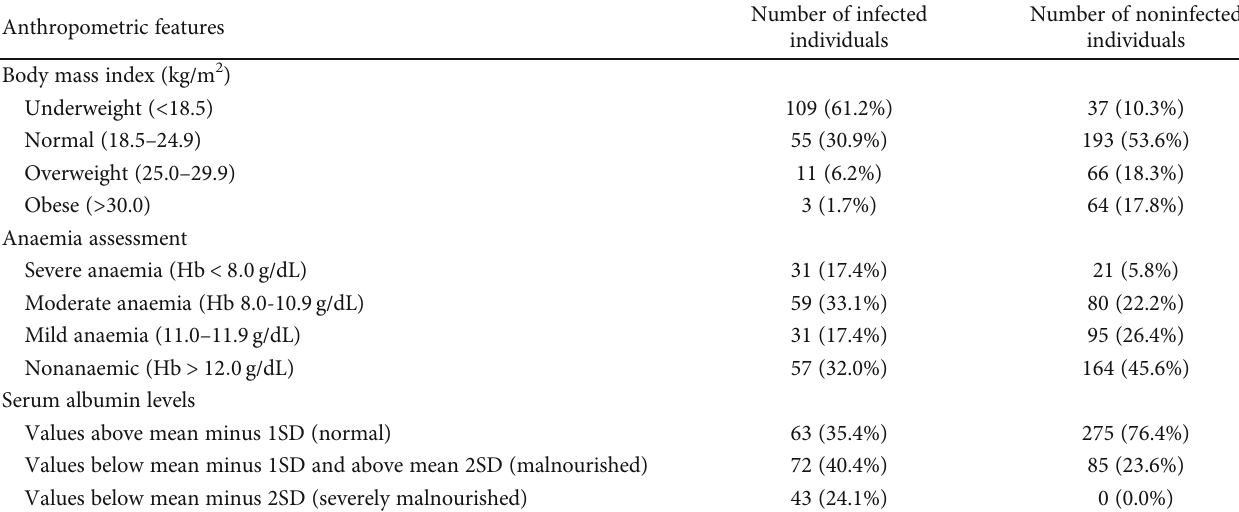
Table 4: Anthropometric parameters and nutritional statuses of infected and noninfected study participants.